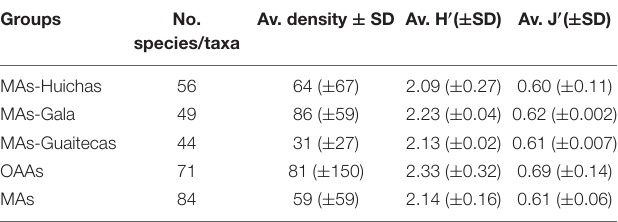
TABLE 4 | Benthic community parameters estimated for MAs and OAAs.